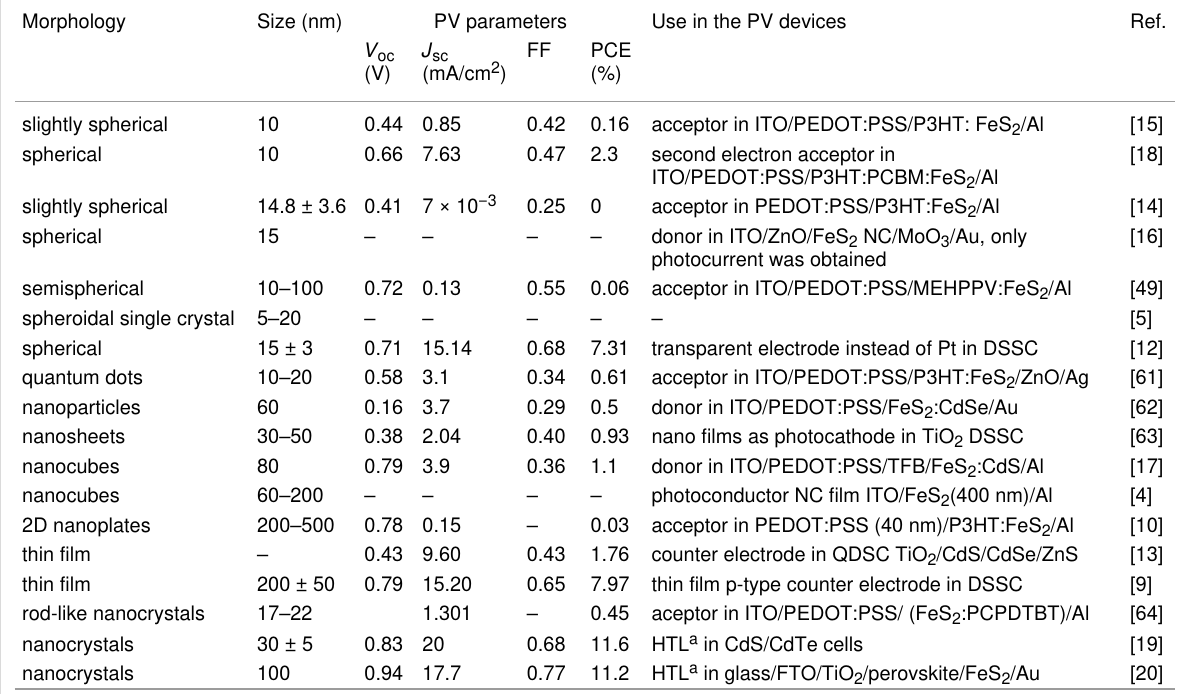
Table 3: FeS 2 structures and influence on the device photovoltaic (PV)